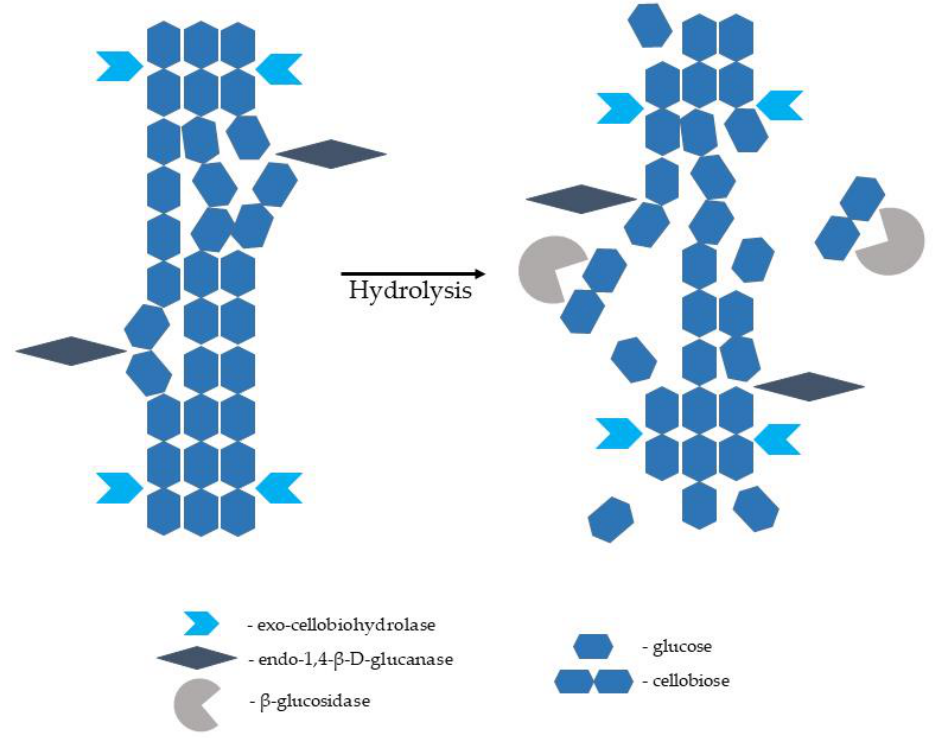
Figure 6. Hydrolysis of native cellulose cellulolytic enzymes (based on [107,110]). Since hemicelluloses represent 10–30% of lignocellulosic biomass, their conversion to fermentable sugars is also vital for the high yield of bioethanol. Hemicellulose hydrolysis is easier than cellulose due to its more accessible amorphous structure. On the other hand, its more varied composition and structure, with multiple side chains